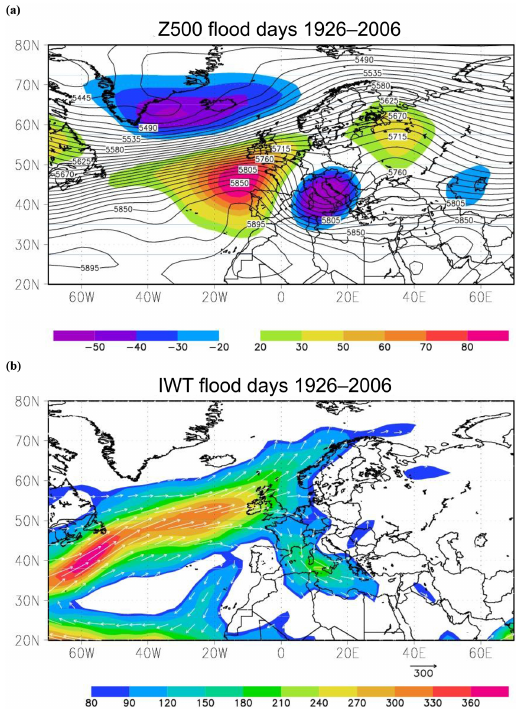
Figure 2. (a) Composite map of daily 500hPa geopotential height (contour) and anomalies (shaded) corresponding to River Ammer floods (discharge higher than 125m 3 s − 1 ) for the period 1926–2006 and (b) composite map of IWT for flood days (vector) and its mag- nitude (color). Units: Z500 (m) and IWT (kgm − 1 s − 1